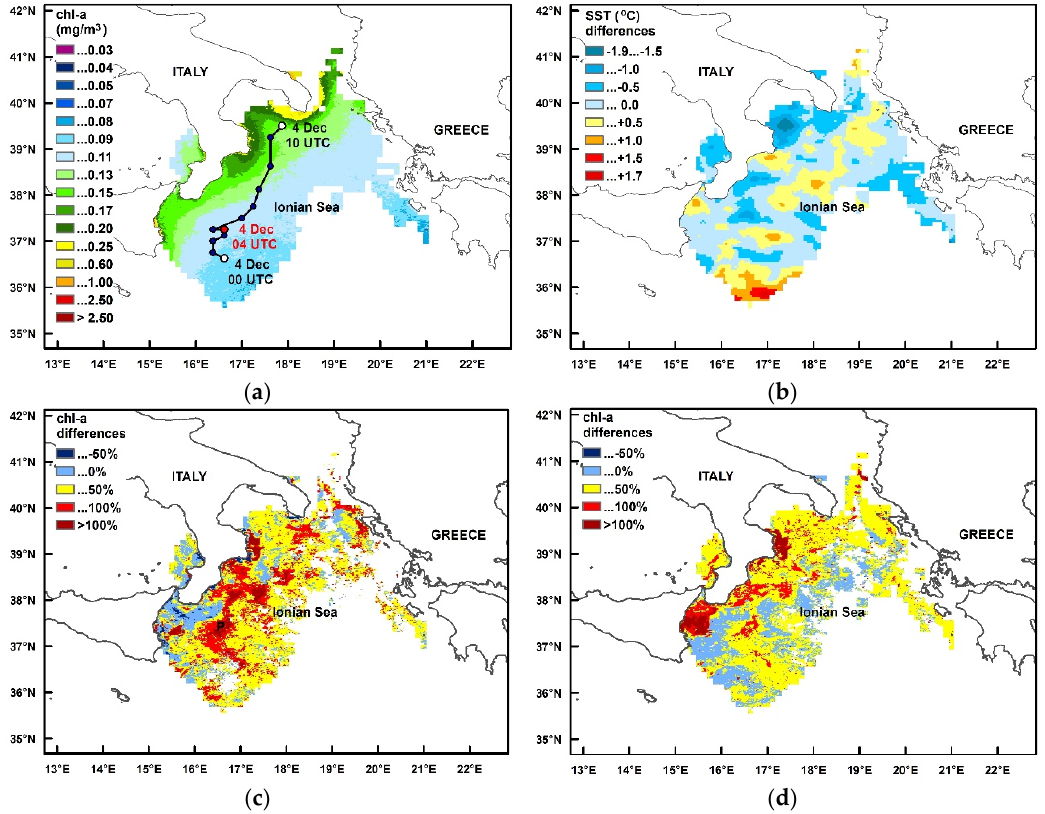
Figure 3. ( a ) The study area together with the mean 1998–2016 chlorophyll-a concentration for December and the medicane’s track. Day and hour refer to the white dots while the red dot denotes the minimum pressure; ( b ) SST differences between 1 and 7 December 2008; ( c ) Chlorophyll percentage differences between the maximum concentrations of 5 days after the event (5–9 December 2008) and 5 days before (28 November–2 December 2008), P denotes the area of large chlorophyll increase referred in the text; ( d ) Same as (c) for the 5 days after the event and 1998–2016 December climatology.